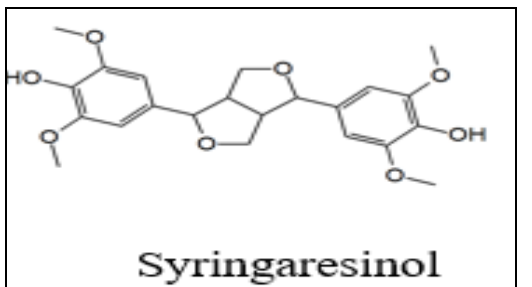
Figure 4. Chemical structure of some coumarines (scopoletin and umbelliferon) (42,43)